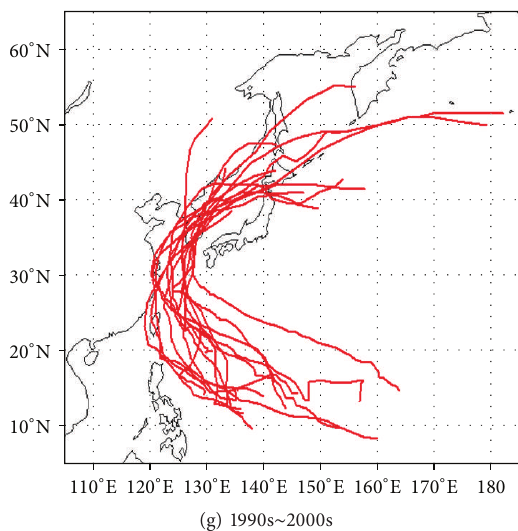
Figure 7: Same as Figure 5, but for TC full-track.